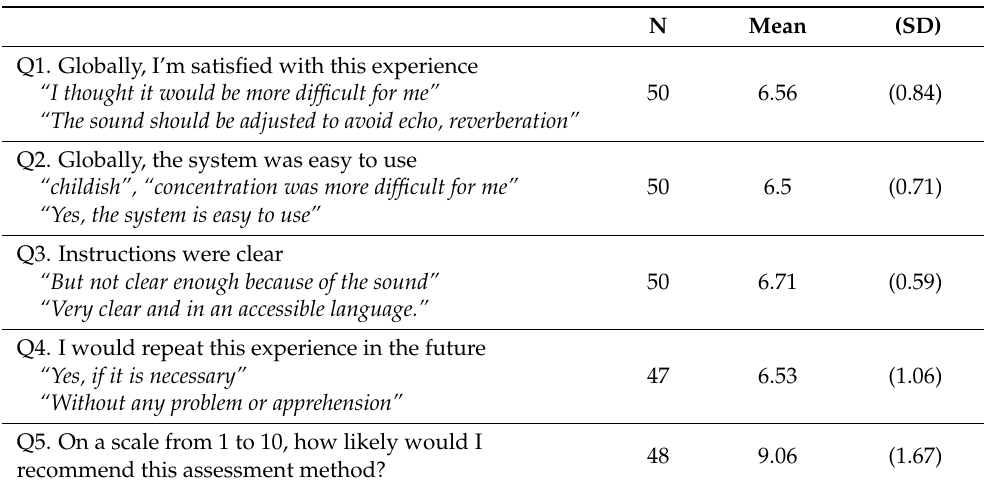
Table 5. Mean scores of the Acceptability